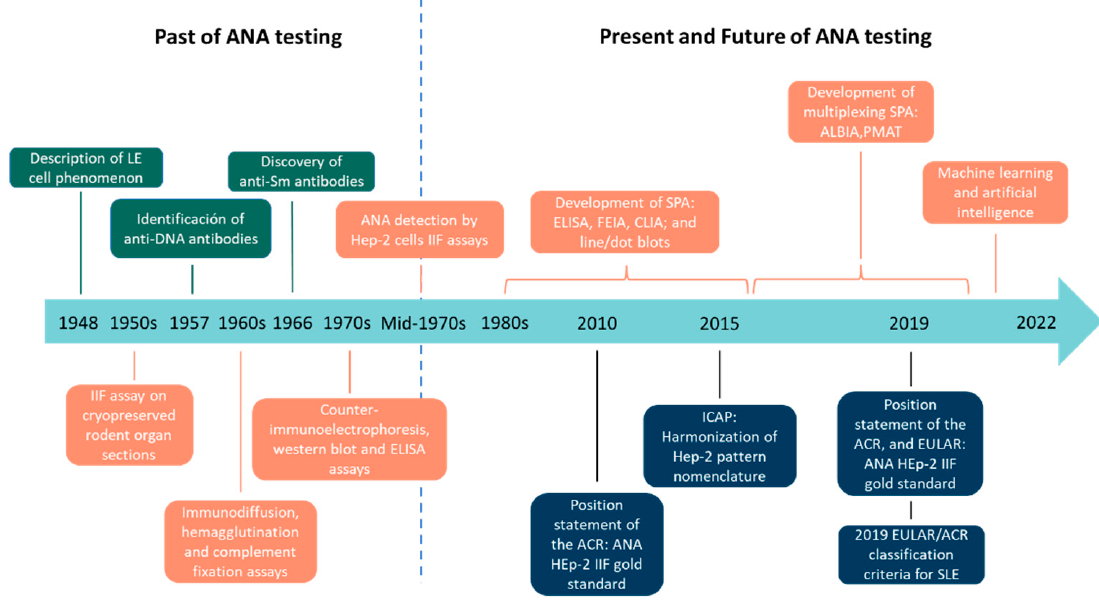
Figure 6. Chronological flow chart including the main events in the past, present, and future of antinuclear antibody (ANA) testing.